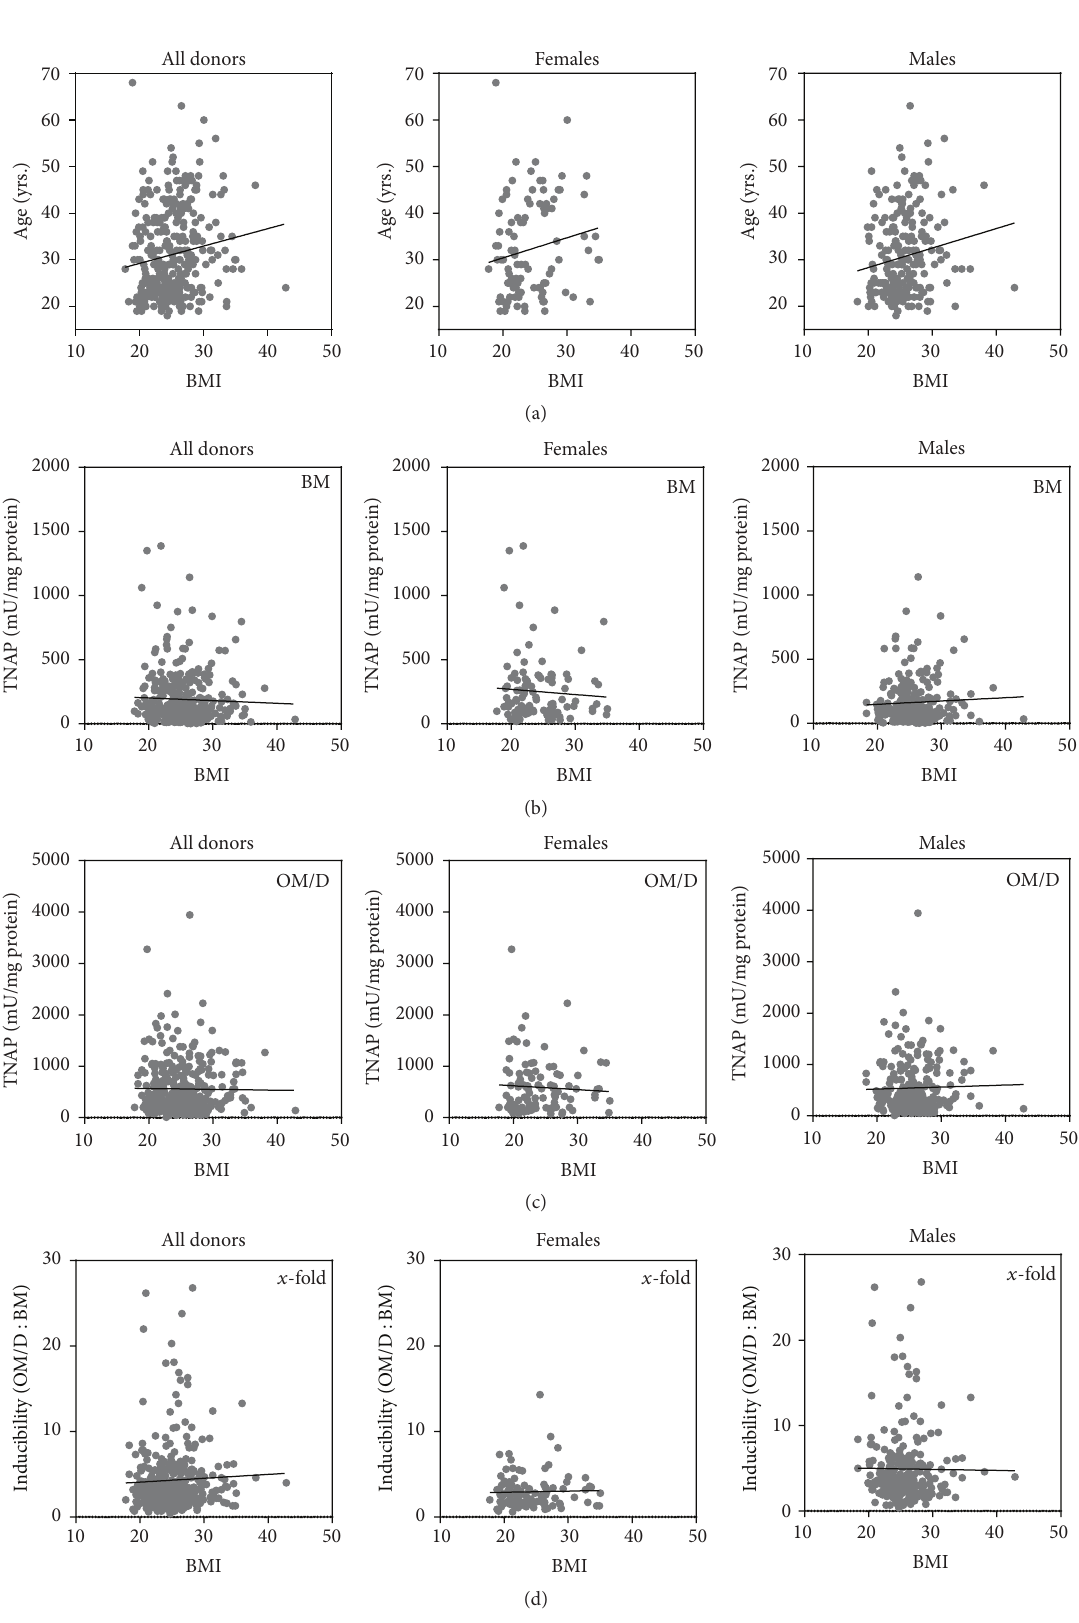
Figure 4: Correlation of body mass index with age, TNAP activity, and inducibility. hBMSC in passage 1 were plated in BM (basic medium) onto TCPS (= P2). From day 4 after plating, the cells were cultured either in BM or in OM/D (osteogenic differentiation medium). At day 15 after plating, the cells were analyzed for TNAP activity as described above. The data was presented for the entire group and females and males as well. Black lines indicate linear curve fit. Regression characteristics ( 𝑝 -value, 𝑅 -square) and the number of analyzed donors are given